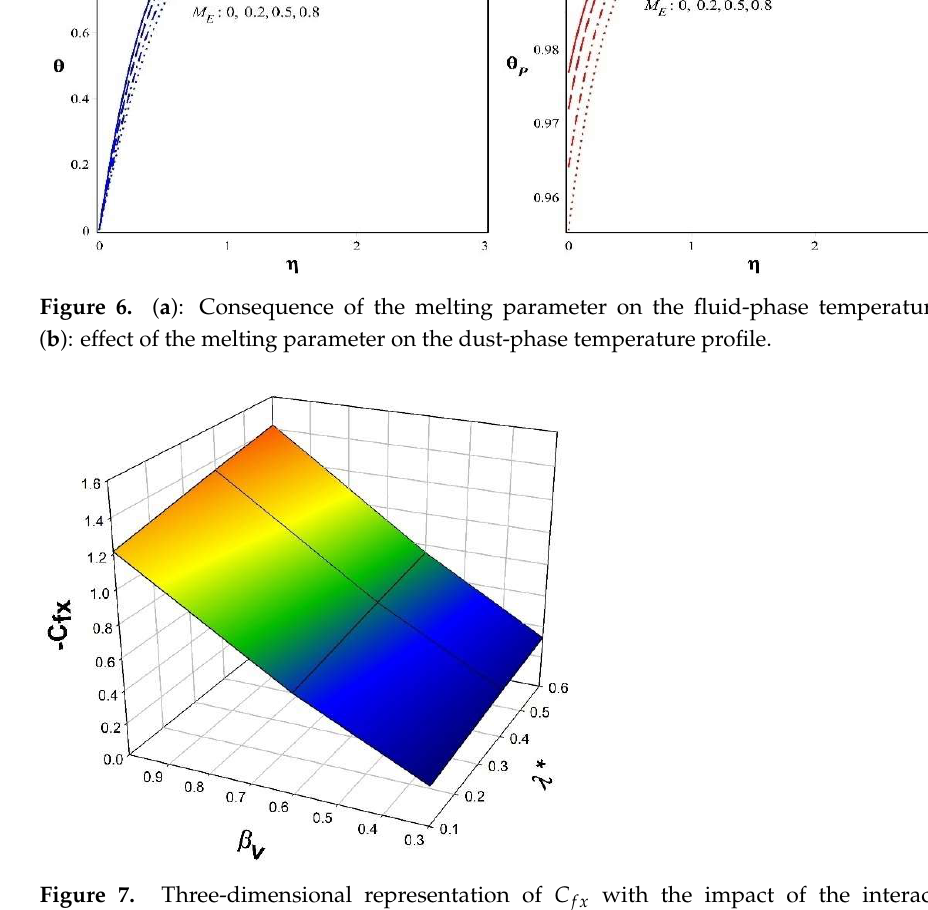
Figure 7. Three-dimensional representation of C fx with the impact of the interaction and porosity parameters.